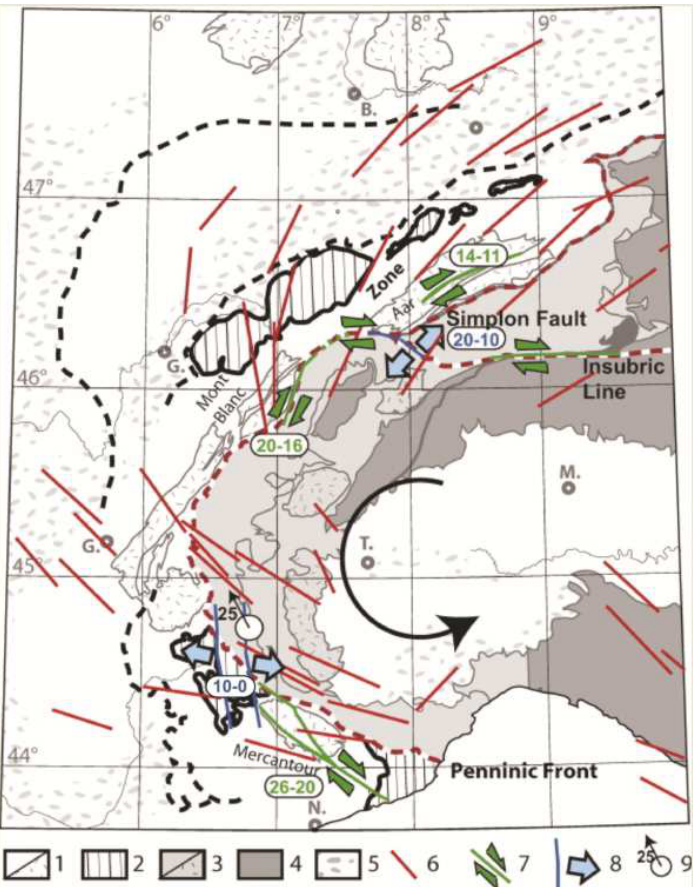
Figure 8. Post–collisional crustal and upper–mantle strain field of the Western Alps with polarities and ages of ductile crustal deformation, and direction of upper–mantle deformation inferred from seismic anisotropies [107]. Age and polarities of displacements are from [58] in the Aar Massif, from [15] in the Simplon Fault Zone, from [13] in the Mont Blanc, and from [60] in the Mercantour. The legend displays: 1, the Dauphinois (or Helvetic) zone, rimmed by the Jura and Alpine frontal thrusts. The Dauphinois zone is comprised of Hercynian crystalline basement (stripped) and its para–autochthonous and allochtonous Mesozoic sedimentary cover (white); 2, the transported klippe of the Helminthoid Upper Cretaceous flysch and Internal Briançonnais and Penninic units. The Internal Alps comprise: 3, the Briançonnais and Piemontais zones, which are made of variably metamorphosed rocks from the continental European margin and the Alpine Tethys oceanic domain; 4, the Austro–Alpine units comprising the Dent Blanche klippe and the Apulian margin; 5, Molasse sediments deposited during the Oligocene to Pliocene lie in the periphery of the Alps. 6, Upper mantle anisotropy defined from systematic SKS splitting measurements [107]. 7 and 8, Main ductile to brittle post–collisional shear zones: 7, strike–slip shear zones; 8 extensional shear zones. 9, Paleomagnetic data obtained in the Briançonnais Zone of SW Alps indicate minimum ∼ 25° counterclockwise rotation [39]. Ductile mid–crustal deformation is evidenced by mylonites formed in a right–lateral kinematic setting along the Alpine arc. These motions are dated at 26–20 Ma in the South [60], at 20–16 Ma in the West (Mont Blanc; [13]) and 20–12 Ma in the North (Aar; [57,58]). This ductile deformation is suggested to continue in the brittle domain, as shown by similar kinematics of faults dated by calcite U/Pb [36] and AFT between 10 and 0 Ma in the southwest part of the arc (Figure 6). Similar kinematics are shown by fault offset of geomorphological features dated by 10 Be on quartz (Figure 4) and seismicity (Figure 3).